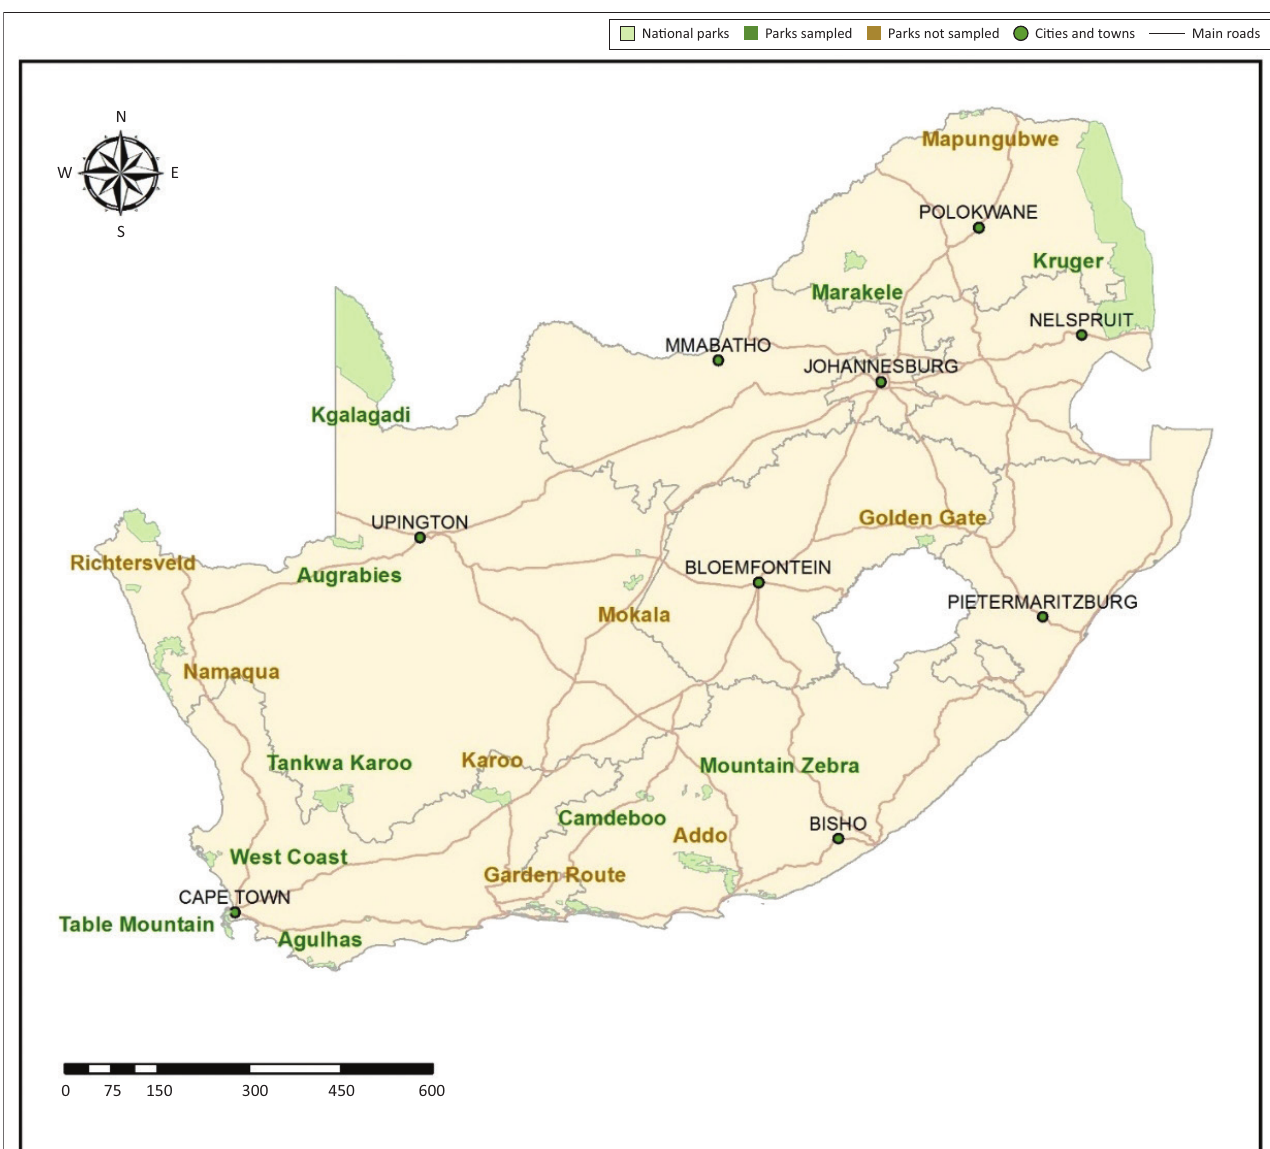
FIGURE 1: Location of national parks included in the sample of Environmental Impact Assessment